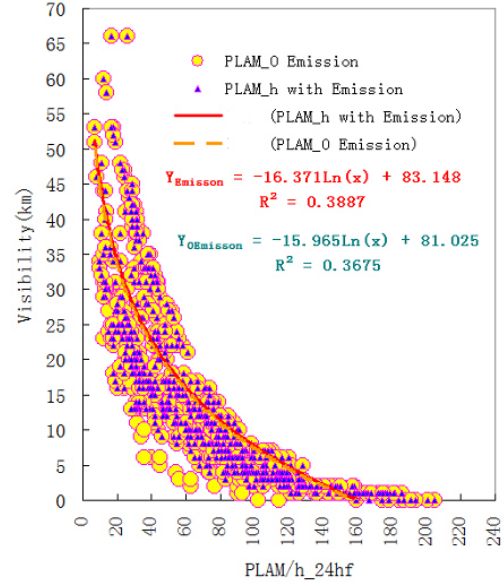
Figure 2. Correlation analysis of PLAM and visibility considering and excluding emission factors on 26 February